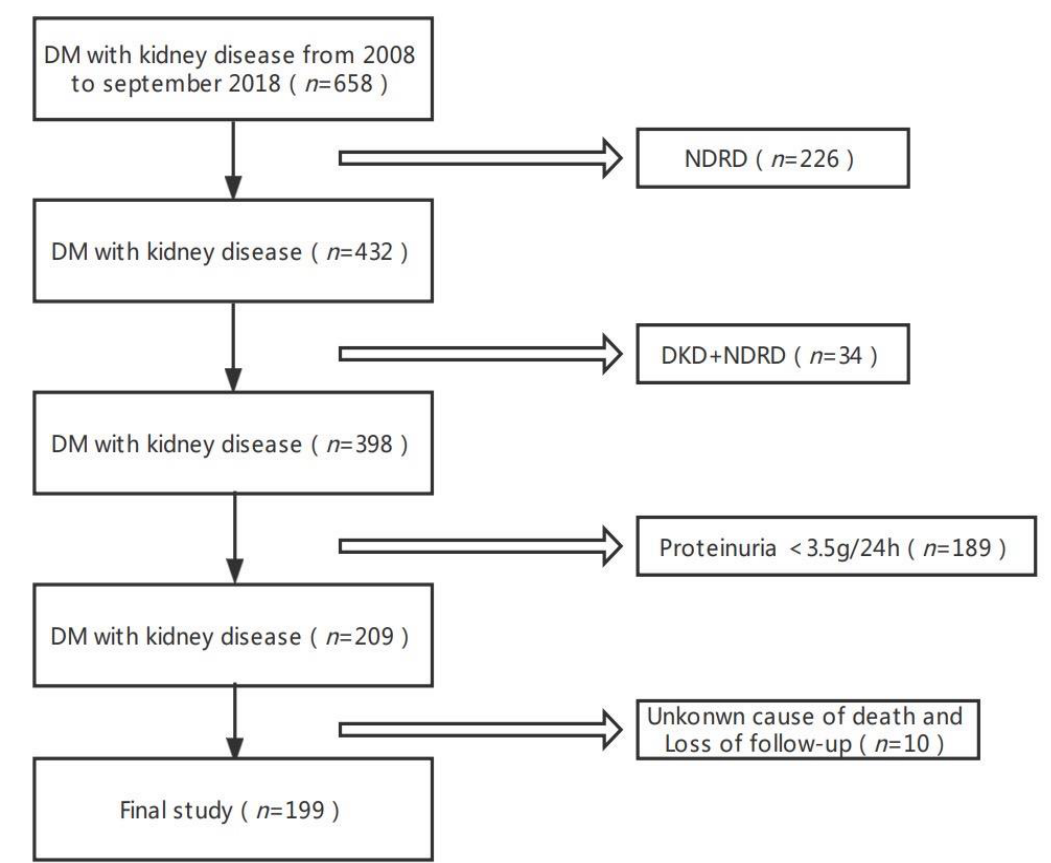
Figure 1. Flowchart of study participants.